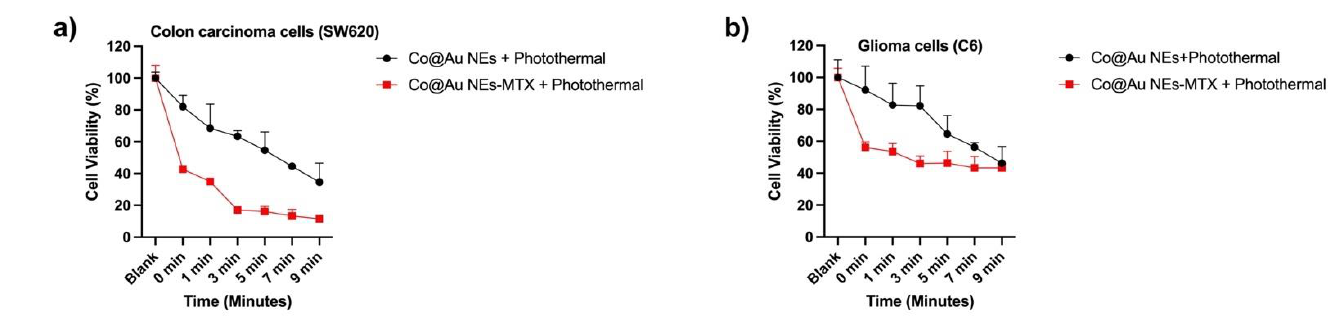
Figure 8. Cytotoxicity of MTX-conjugated elliptical Co@Au (Co@Au NEs) nanoparticles towards SW620 colon carcinoma and C6 glioma cells, respectively, after photostimulation. ( a , b ) Photothermal treatment-induced detachment of MTX caused higher cell death in both cell lines (red line); however, the effect was more pronounced in Colon carcinoma cells.